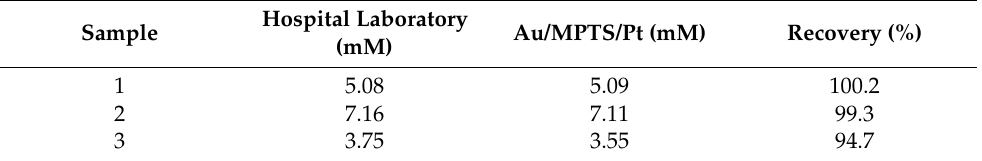
Table 2. Determination of glucose in human blood serum samples.